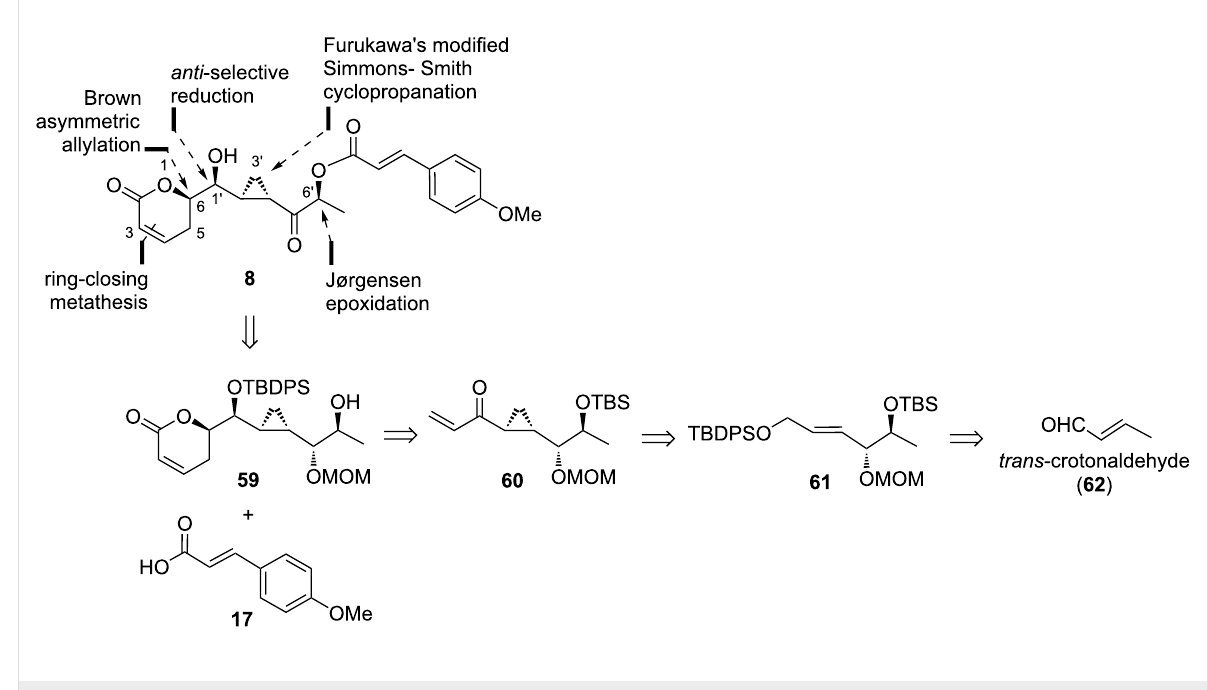
Scheme 6: Retrosynthetic analysis of brevipolide H ( 8 ) by